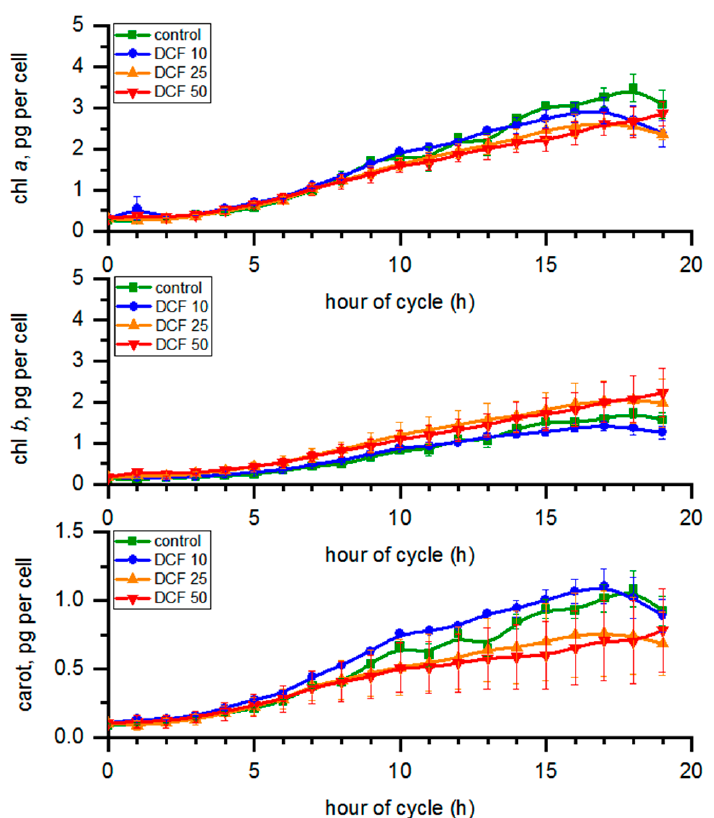
Figure 2. The photosynthetic pigment content calculated per single mother cell. Data are presented as means ± SE. Chlorophyll b and carotenoid content of DCF25 were statistically significantly different from the controls. Chlorophyll a , chlorophyll b and the carotenoid content of DCF50 were statistically significantly different from controls (correlation comparison, p < 0.05, n = 3). Data are presented as pg per mother cells even at the time of cell division to allow simple comparison across the groups.